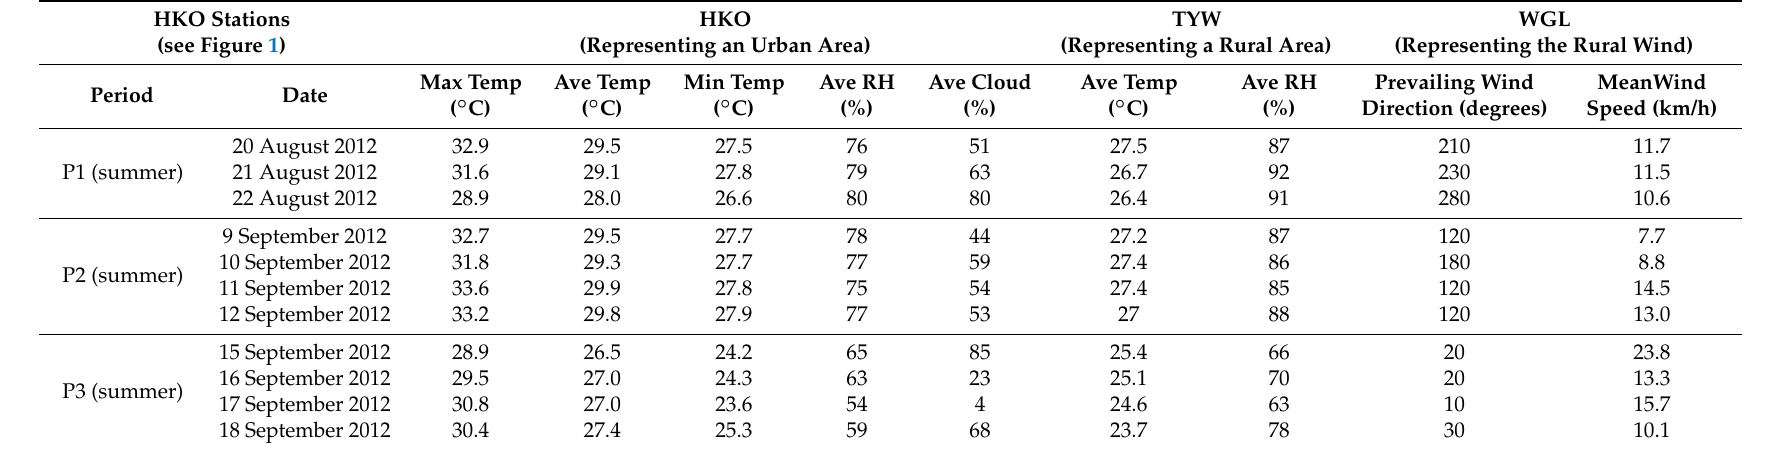
Table A1. Weather conditions during the measurement periods at three HKO weather